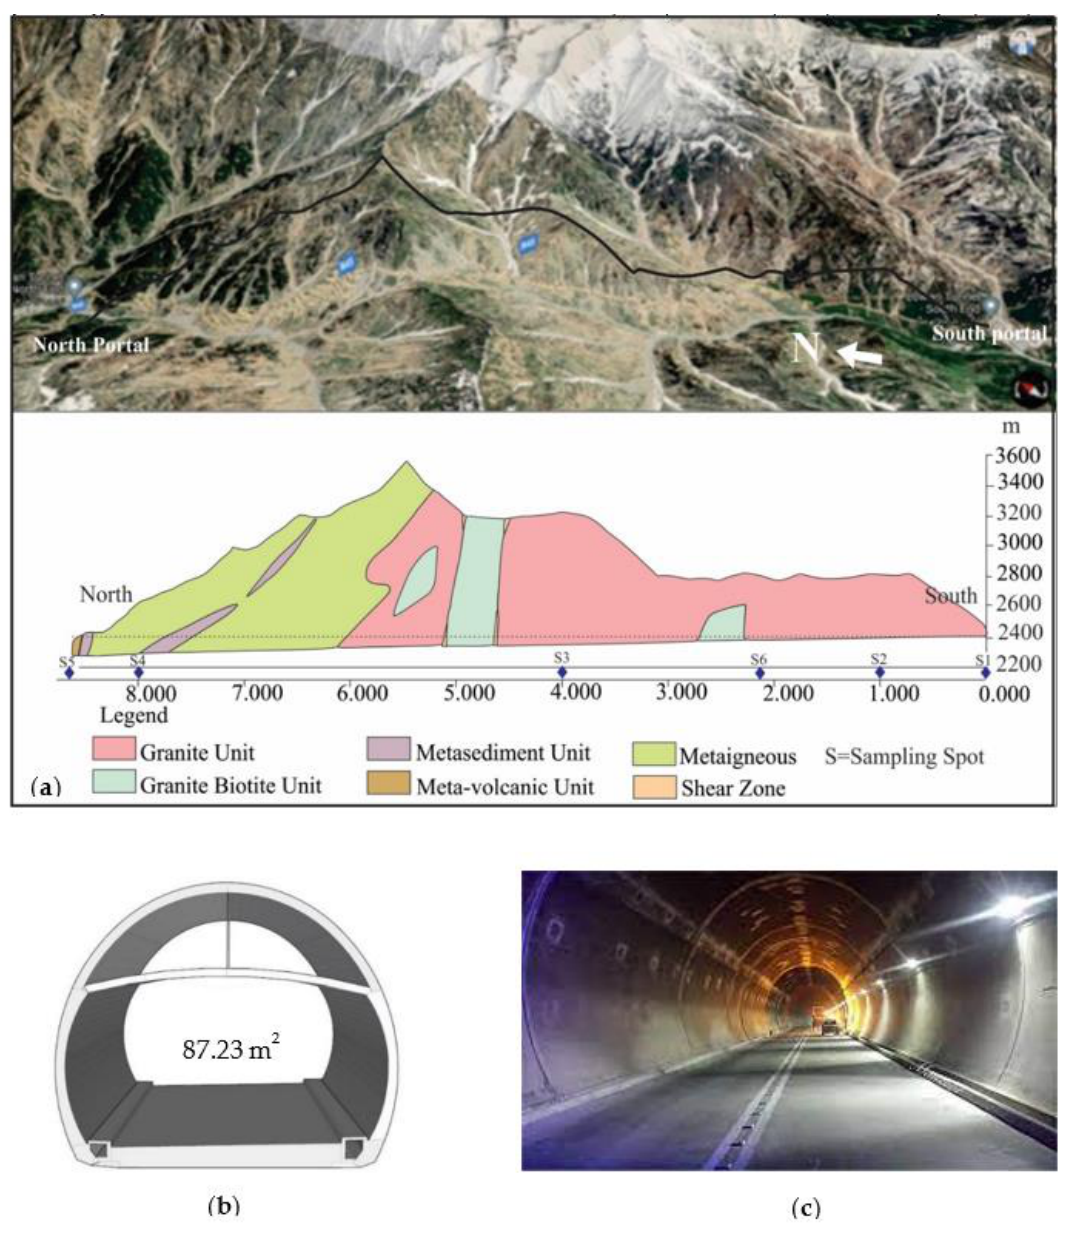
Figure 1. ( a ) Tunnel length, geological units and overburden (modified from Ur Rehman, et al. [40]. ( b ) Lowari Tunnel ’s profile. ( c ) Real-time image.